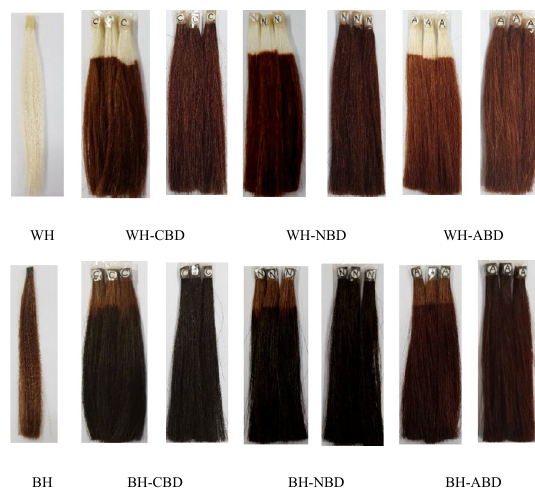
Fig. 1 White hair (WH) and bleached hair (BH) after dyeing with Cationic (CBD), Nonionic (NBD), and Anionic (ABD) basic hair